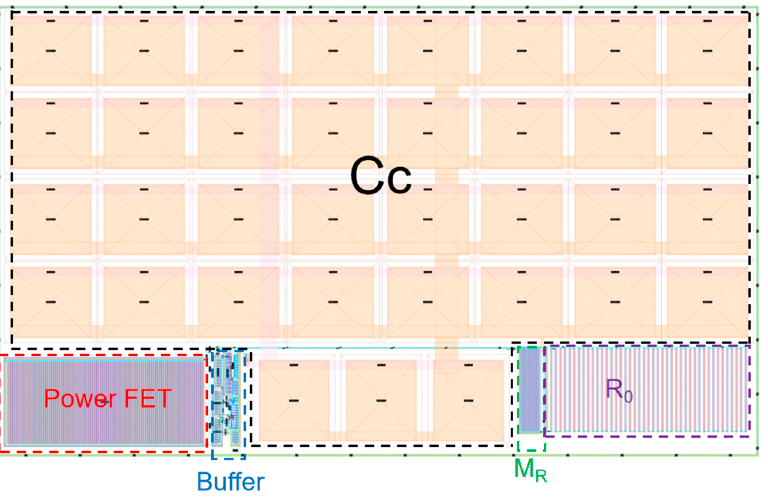
Figure 9. Layout of the proposed OCL-LDO.